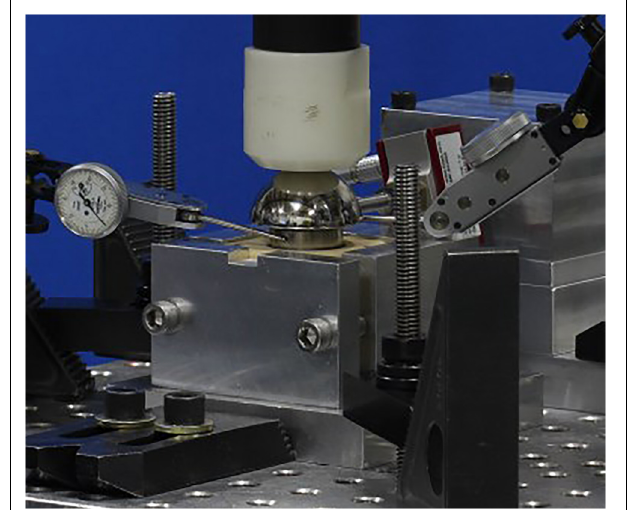
FIGURE 5 | A representative laboratory test setup showing axial compression and shear load